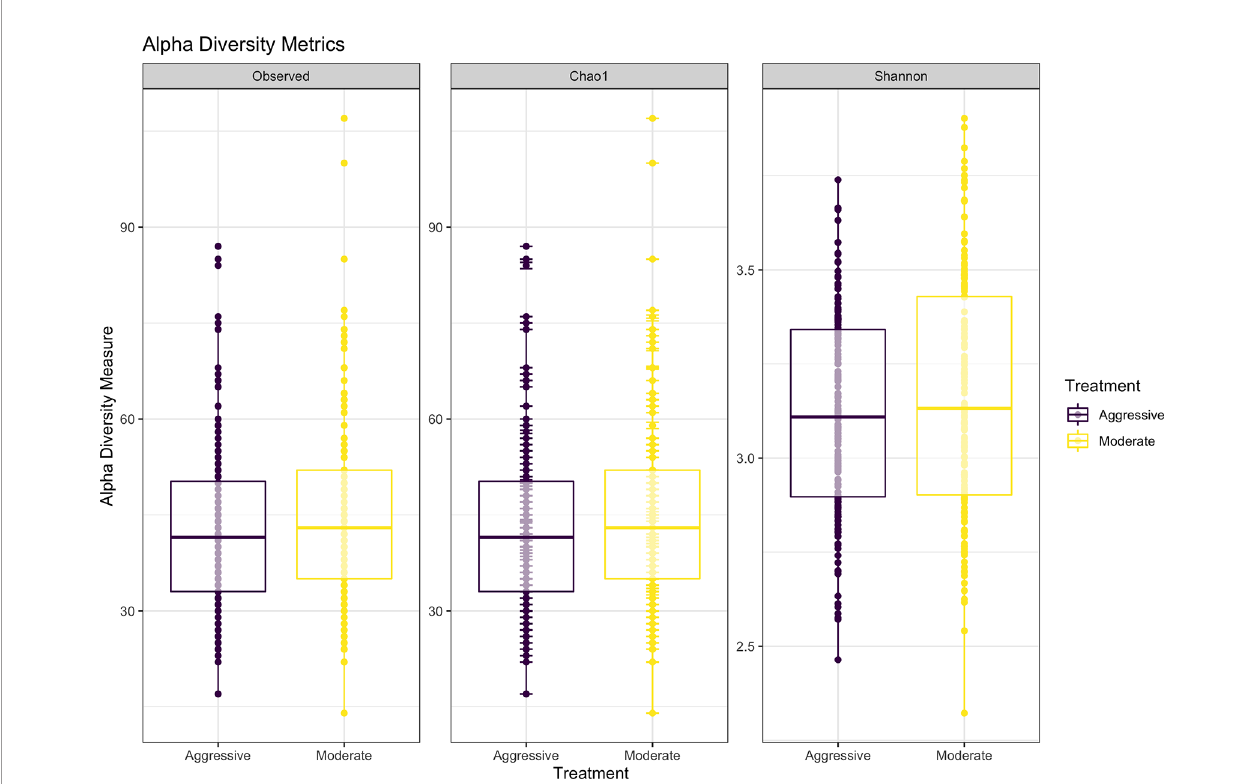
FIGURE 5 | Alpha-diversity metrics for archaeal communities with observed abundances of communities, expected abundances (Chao1), and richness and diversity measured with Shannon diversity index. Aggressive treatments are represented in purple and moderate treatments are represented in yellow. There were no signi fi cant differences between alpha-diversity metrics between moderate and aggressive implant